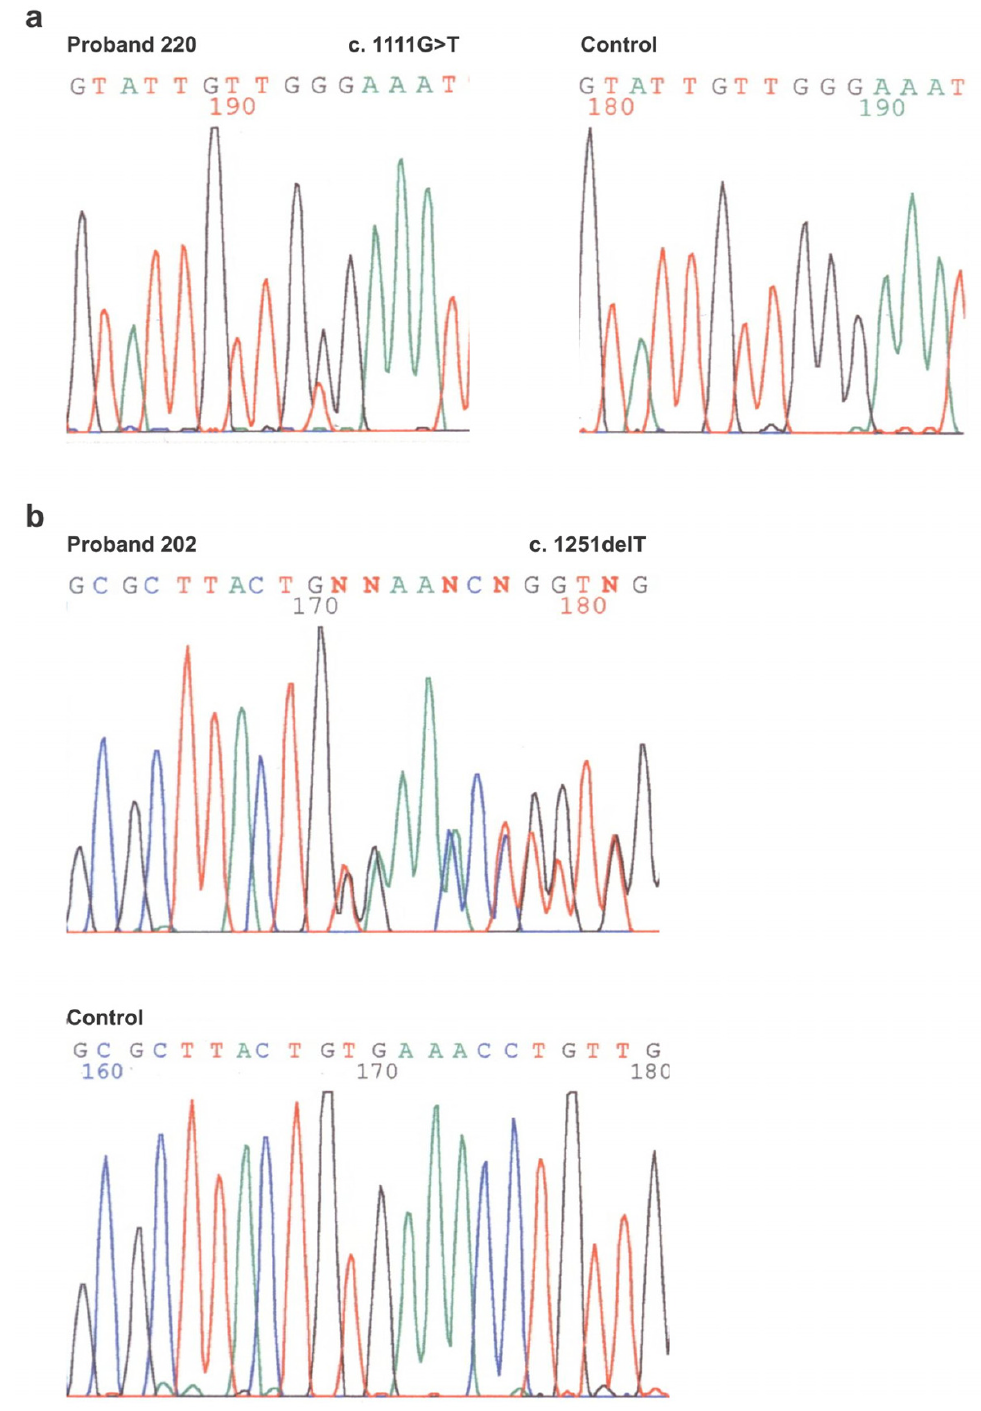
Figure 2 Analysis of APC germline mutations of exon 9. a . Sequencing pattern of alternatively spliced part of the exon 9 (forward) in proband of the family 220 (AFAP phenotype) with heterozygous substitution G>T at nucleotide position 1111 (p.Gly371X) and control b . Sequencing pattern of part in the regularly spliced region of the exon 9 (forward) in proband of the family 202 (FAP phenotype) with heterozygous deletion T at nucleotide position 1251 (p.Cys417TrpfsX37) and